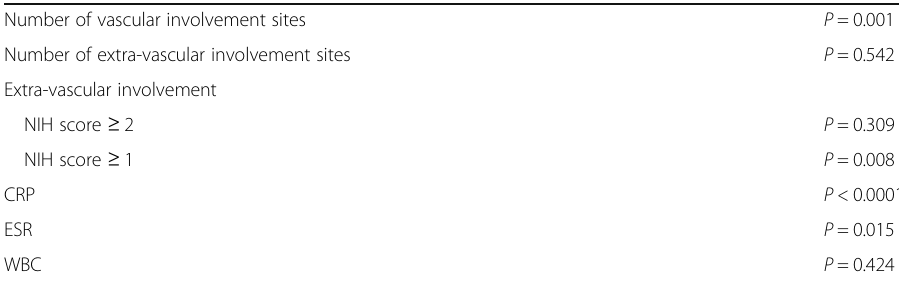
Table 5 Factors correlated with disease activity (NIH score ≥ 2) Number of vascular involvement sites P = 0.001 Number of extra-vascular involvement sites P =